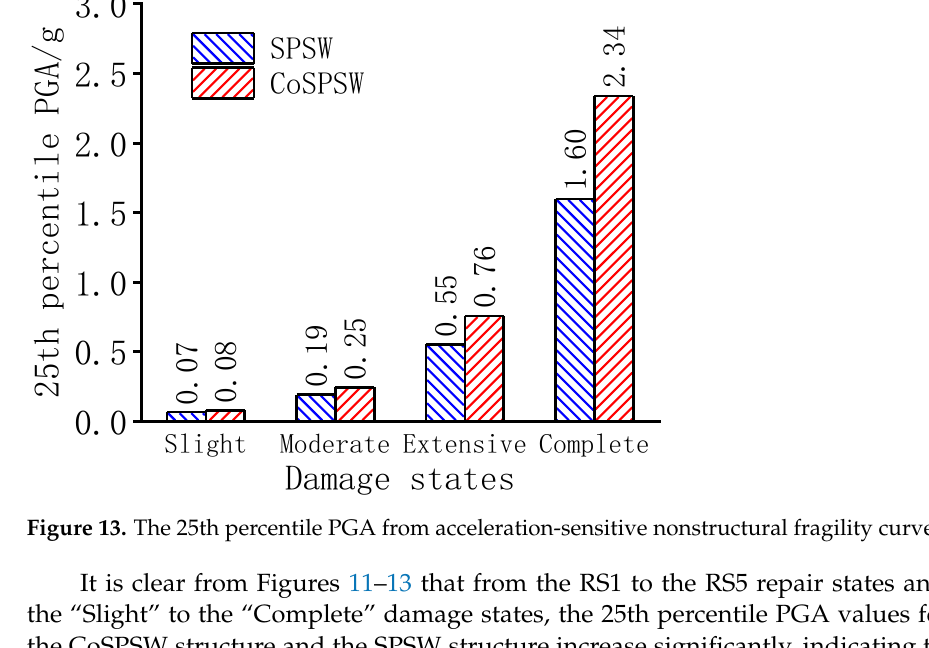
Figure 12. The 25th percentile PGA from drift-sensitive nonstructural fragility curves.